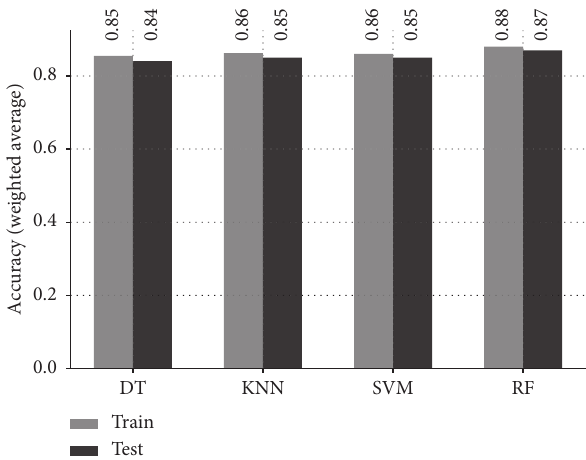
Figure 10: Results for training and test